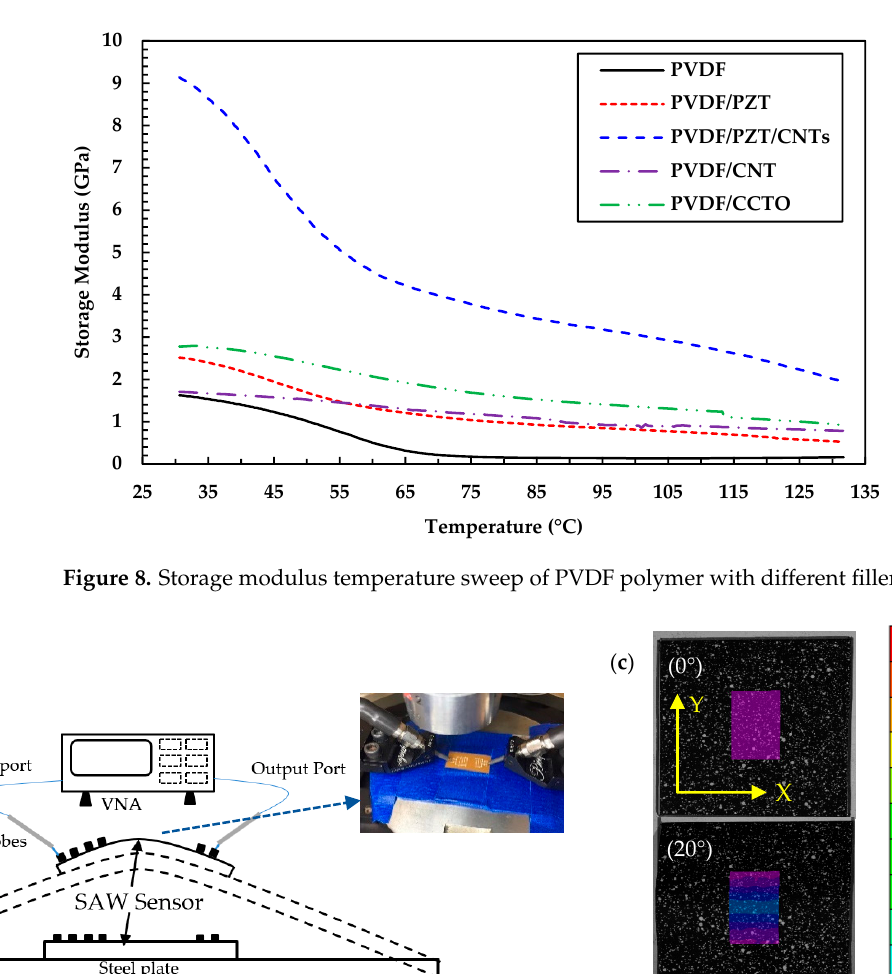
Figure 8. Storage modulus temperature sweep of PVDF polymer with different fillers at 1 Hz.